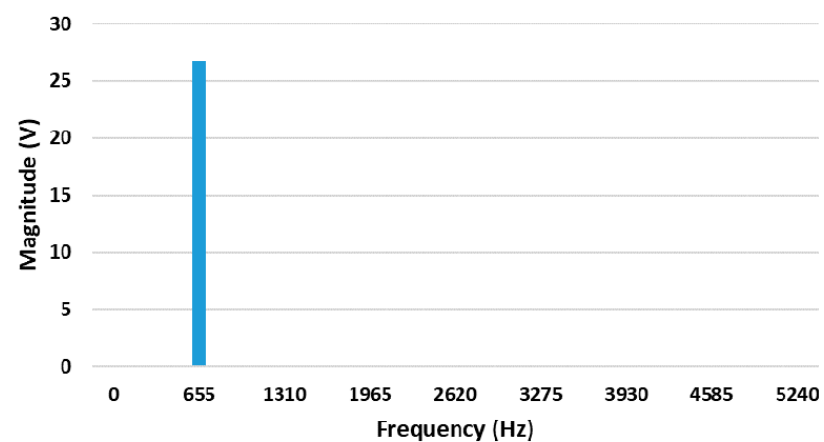
Figure 27. Harmonic spectrum of the measured e.m.f.